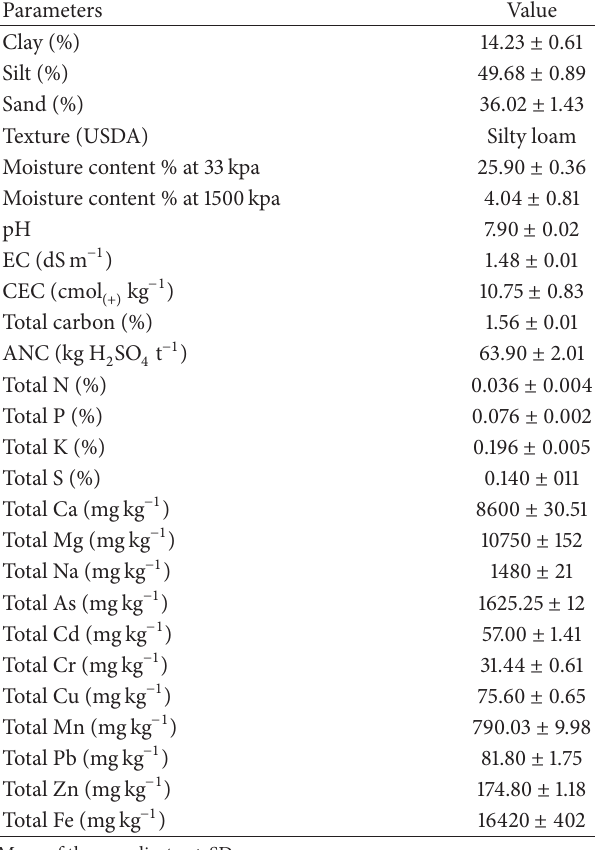
Table 2: The selected physicochemical properties of the gold mine tailings.